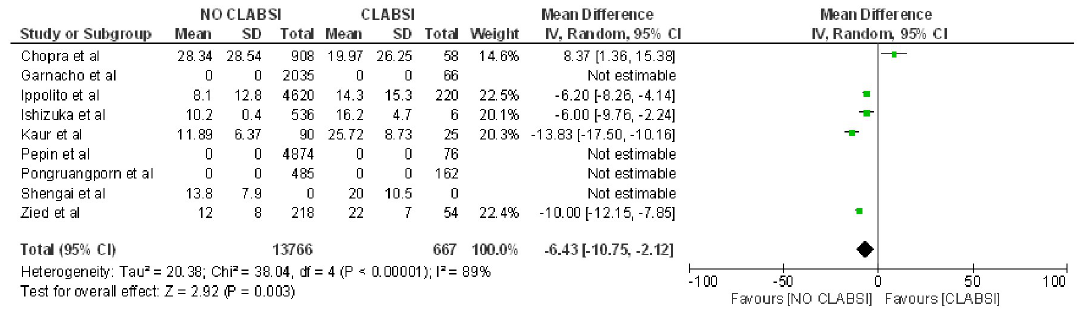
Fig 8. Forest plot of catheter days and CLABSI.